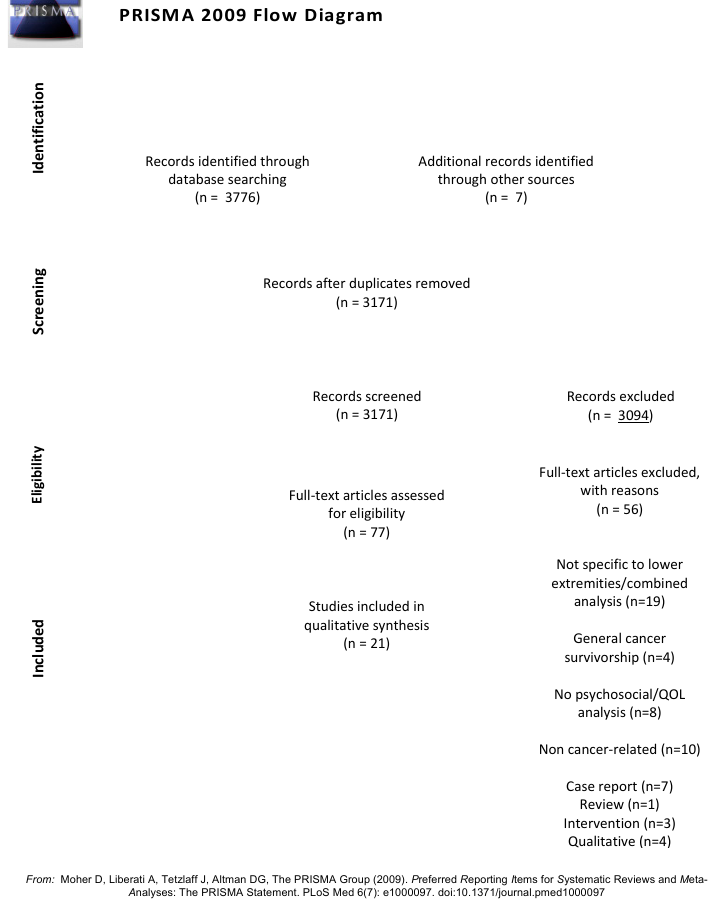
Figure 1. The PRISMA flow diagram demonstrating article screening outcomes and reasons for exclusion [20].